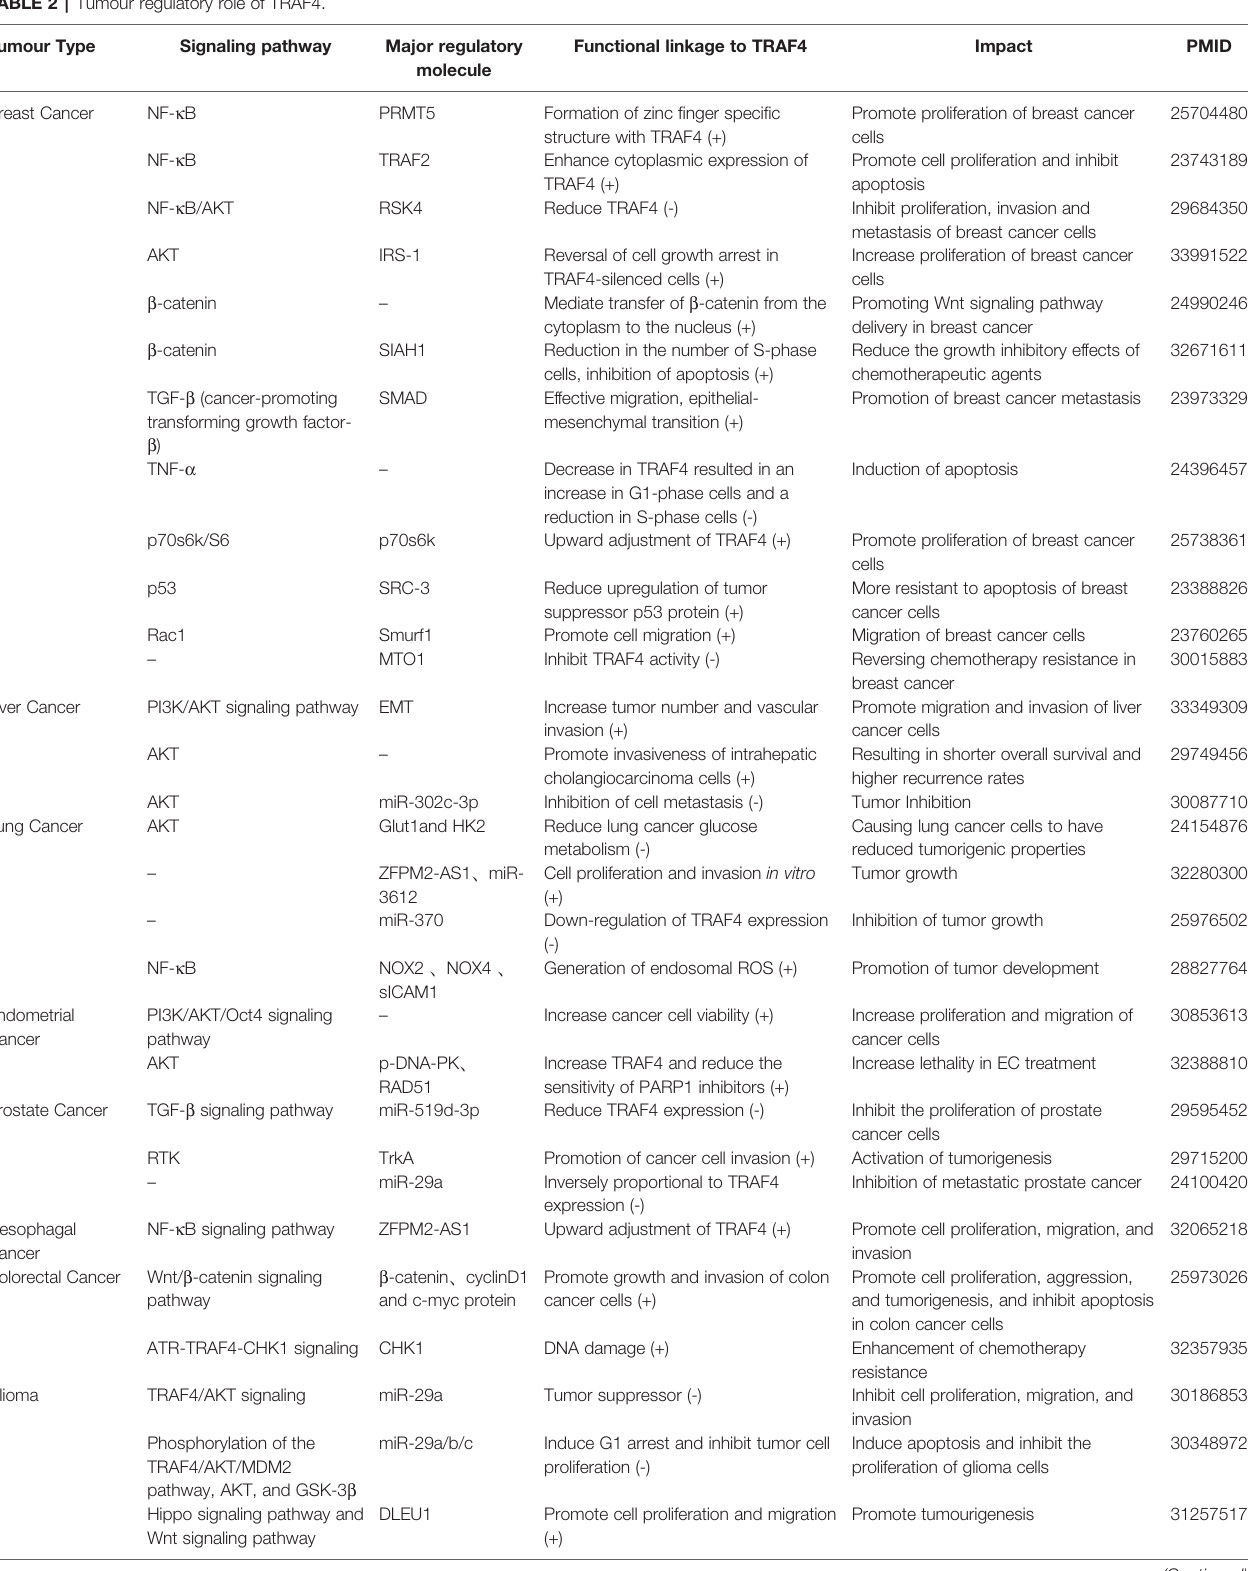
TABLE 2 | Tumour regulatory role of